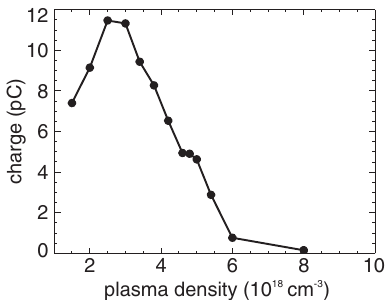
FIG. 7. Trapped charge as a function of the plasma density for laser parameters a 0 ¼ 2 , L 0 ¼ 11 . 47 μ m and w 0 ¼ 7 . 26 μ m.